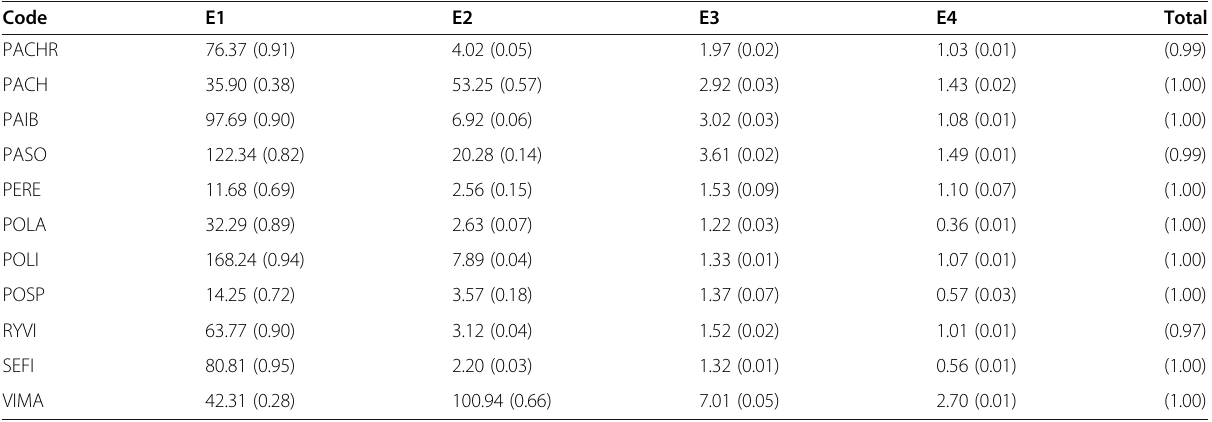
Table 6 Outputs for each potential habitat suitability model of plant species in Santa Cruz Province. Eigenvalues and percentage of explained information corresponded to the first four axes